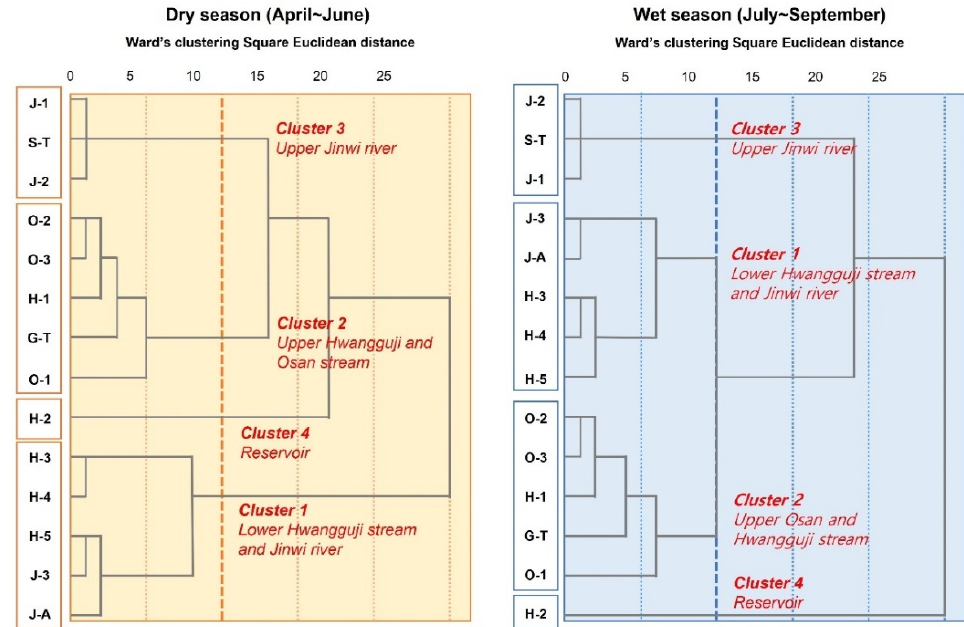
Figure 5. Dendrogram of the 14 monitoring sites using hierarchical cluster analysis.